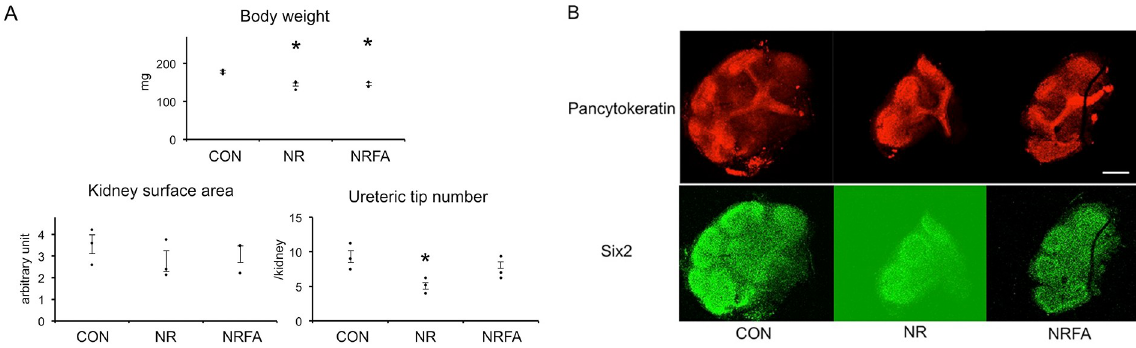
Fig 1. Effect of folic acid supplementation on the reduction in body weight and ureteric tip number induced by maternal nutrient restriction at embryonic day 14. (A) After fetal weight was recorded, kidneys were isolated, fixed with methanol, and stained with anti- pancytokeratin antibody and anti-Six2 antibody. The number of ureteric bud tips was counted observing z-stack images by confocal microscopy. Kidney surface area was measured by ImageJ software and expressed in arbitrary units. The mean value of each litter was used for statistical analysis (ANOVA followed by Tukey’s test). CON, controls; NR, offspring of nutrient-restricted mothers; NRFA, offspring of nutrient-restricted mothers supplemented with folic acid. n = 3 litters, n = 4–6 animals per litter. Dots indicate the mean value of each litter. Bars represent ± SE. � , P < 0.05 vs CON. (B) Representative images. Scale bar, 250 μ